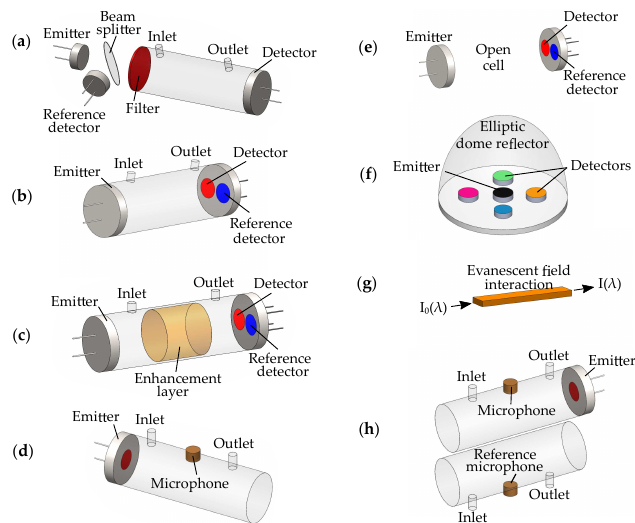
Figure 2. Optical gas sensor based on the Beer–Lambert’s law. ( a ) No signal detected when the emitter is off. ( b ) The detected signal is at a maximum when the emitter is on and no gas is present, and is decreasing ( c ) with the gas concentration, c , when the gas is present.